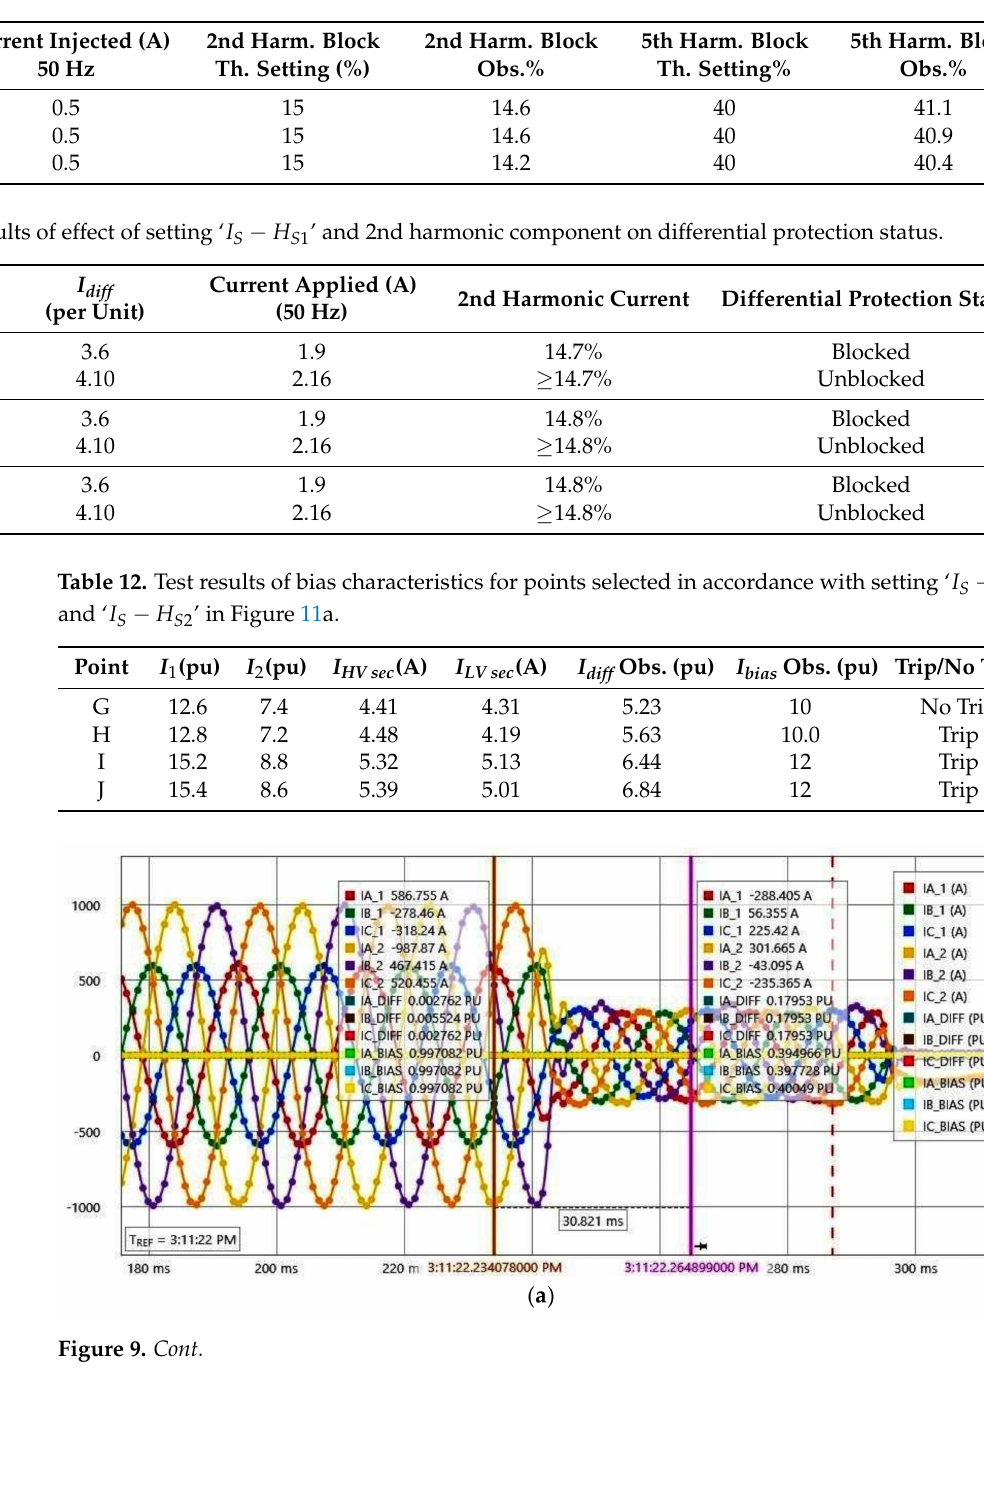
Table 10. Results of 2nd and 5th harmonic restraint test.